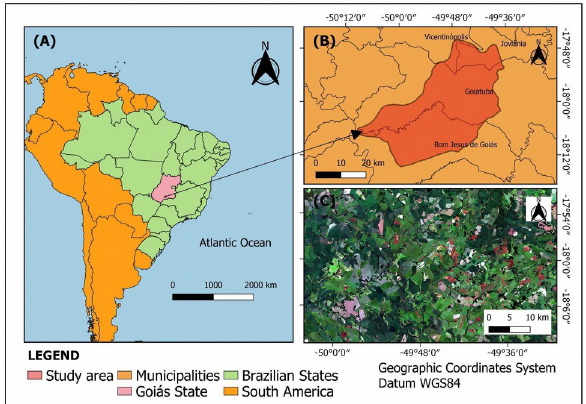
Figure 1 . Santa Barbara watershed (study area) in the Goiás State, Brazil. The true-color composition (Red-Blue-Green) (C) is part of the Harmonized Landsat 8 Sentinel-2 collection from 21 April 2021. Base maps were obtained from the Brazilian Institute of Geography and Statistics (IBGE) and Goiás State Geoinformation System